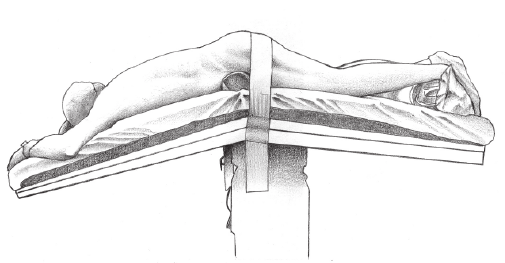
Figure 3 - Planes incised and repaired, exposing the rectal wall, and identification of the